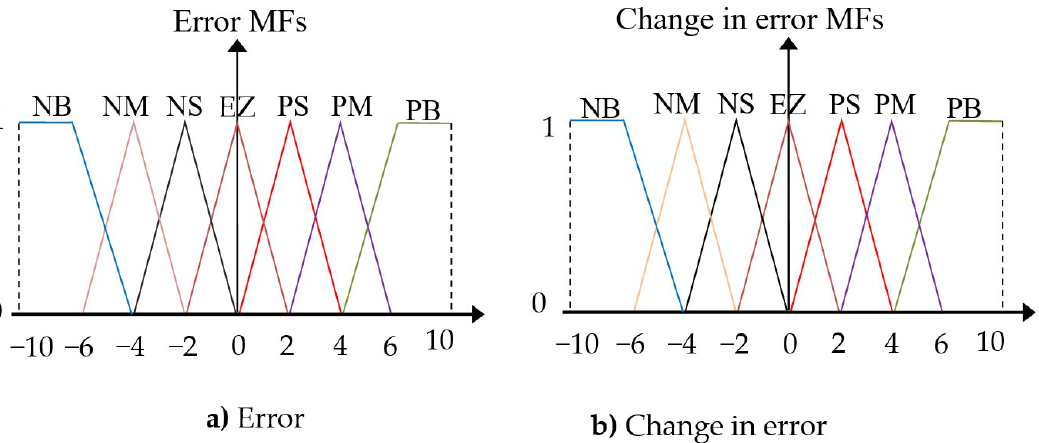
Figure 5. Membership functions.